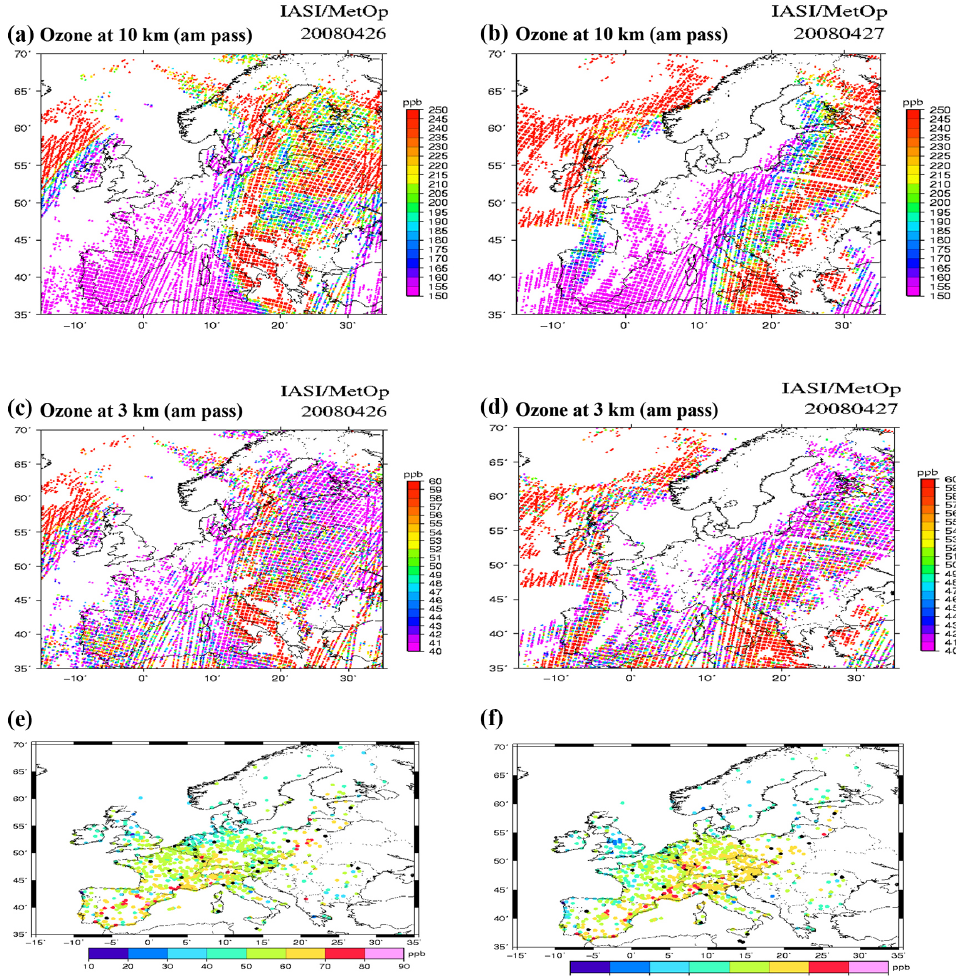
Figure 4. Daily IASI satellite ozone measurements (ppb) at 10km level ( a, b ; in ppb) and at 3km level ( c, d ; in ppb) for 26 April 2008 (left column) and 27 April 2008 (right column). Values outside the scale range are set up to the upper and lower color code. (e, f) Hourly average surface ozone (EEA-AirBase) mixing ratios (ppb) at 15:00 for 26 April 2008 (left column) and for 27 April 2008 (right column). Ozone data are from the EEA-AirBase